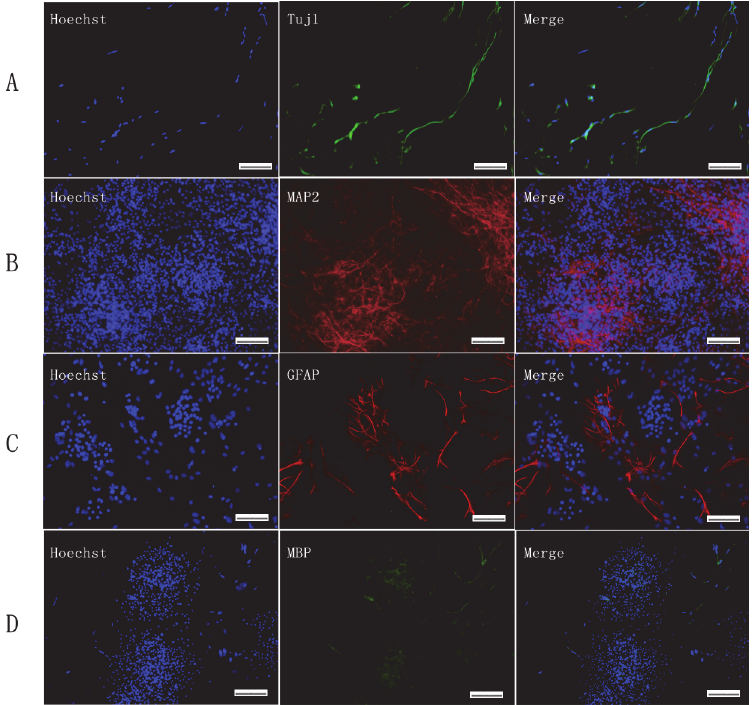
Fig 7. Immunofluorescence of differentiated iNSCs. Neurons, oligodendrocytes, and astrocytes were assessed by immunofluorescence for Tuj1 (A), MAP2 (B), GFAP (C), and MBP (D). Scale bars = 100 μ m (A, C), 200 μ m (B,